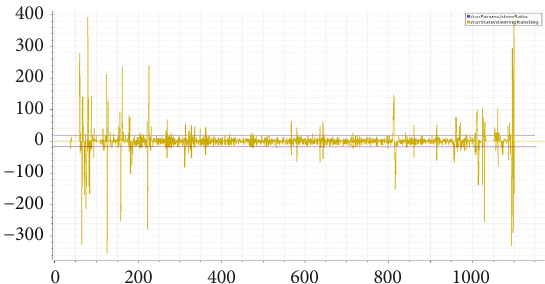
Figure 31: T1N1 left (1) and right (2) lane recognition.